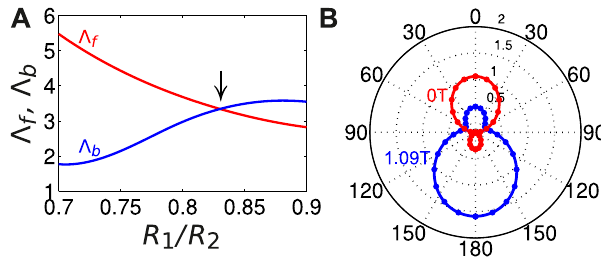
Figure 4: Optimization of the setup versus R 1 / R 2 , while R 2 (cid:2) 10 μ m, in both forward- and back-scattering operation to achieve equal directionality. (A) Ratios Λ f , Λ b versus R 1 / R 2 for which the setup supports active directionality inversion. Red: Λ f ; blue: Λ b . The black arrow indicates the value R 1 / R 2 (cid:2) 0 . 836 where Λ f (cid:2) Λ b . This point corresponds to λ b / R 2 (cid:2) 7 . 6 and B (cid:2) 1 . 09 T. (B) σ / ( π R 2 λ / R (cid:2) 7 . 6. Red: forward-scattering at 0 T; blue: back-scattering at 2 b 1.09 T. Curves: VIE; dots: